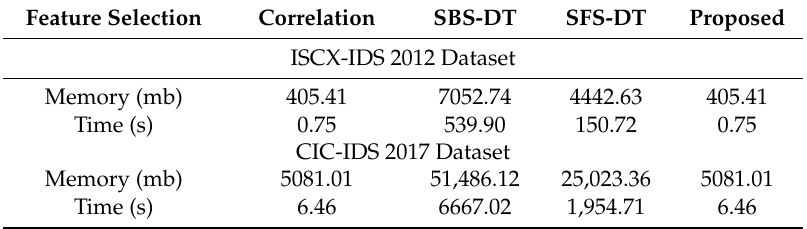
Table 6. Memory and time consumption comparison between the proposed and other feature selection methods.